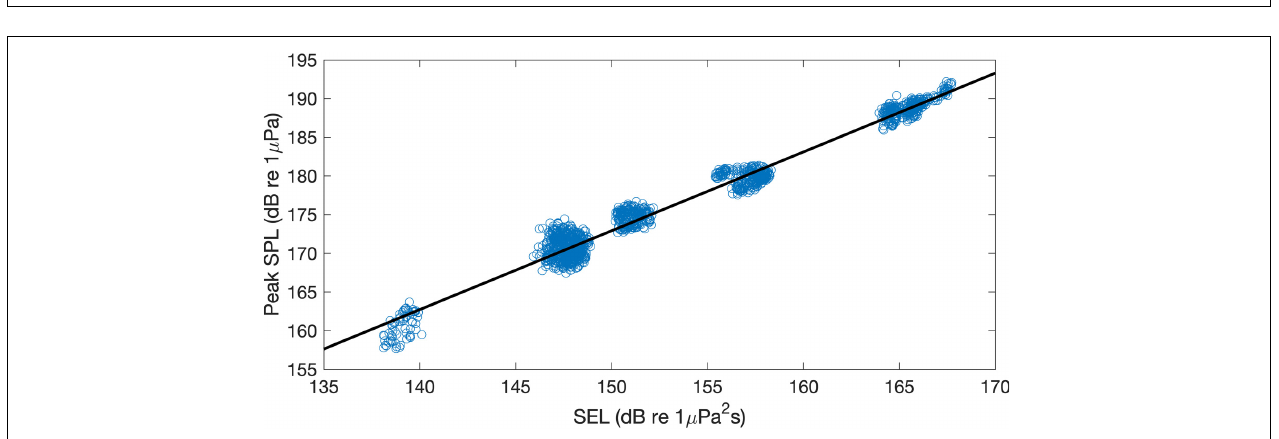
FIGURE 11 | The relation between peak sound pressure level and sound exposure level estimated from the data recorded at the six distances and three depths (blue circles). The black line represents the best-fitted regression curve, which is equal to L P = L E +